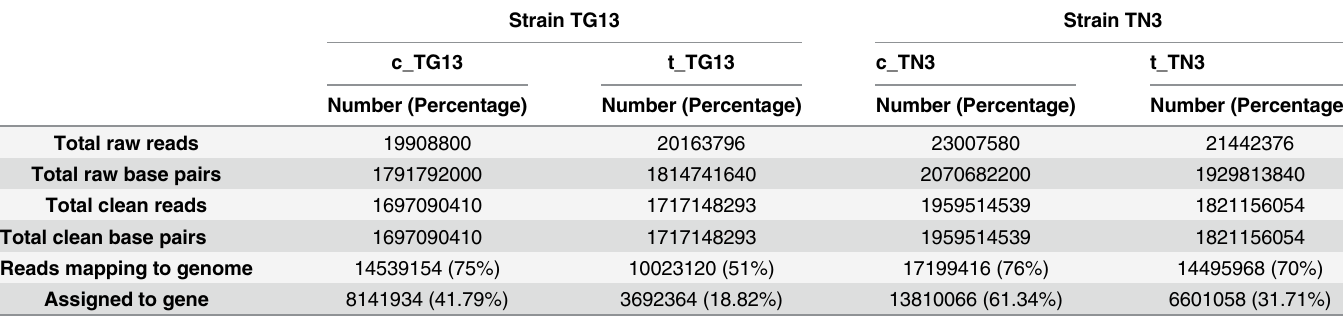
Table 1. An overview of the RNA-Seq statistics.